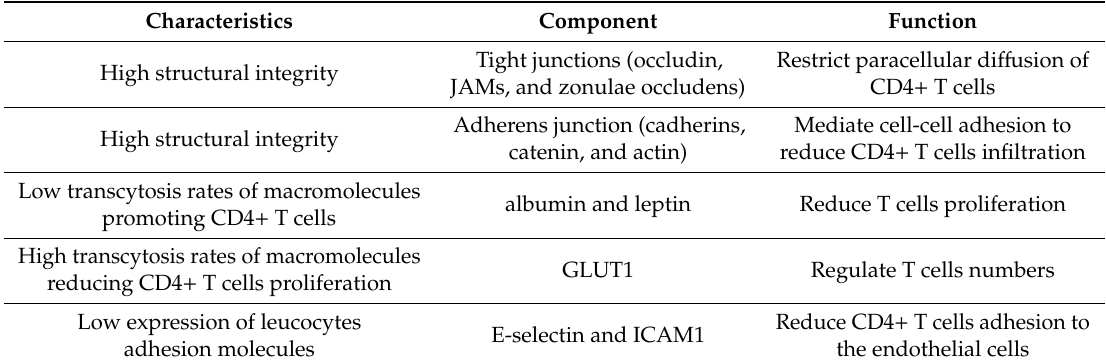
Table 2. The e ff ect of endothelial cells characteristics on CD4 + T cells migration in homeostasis.